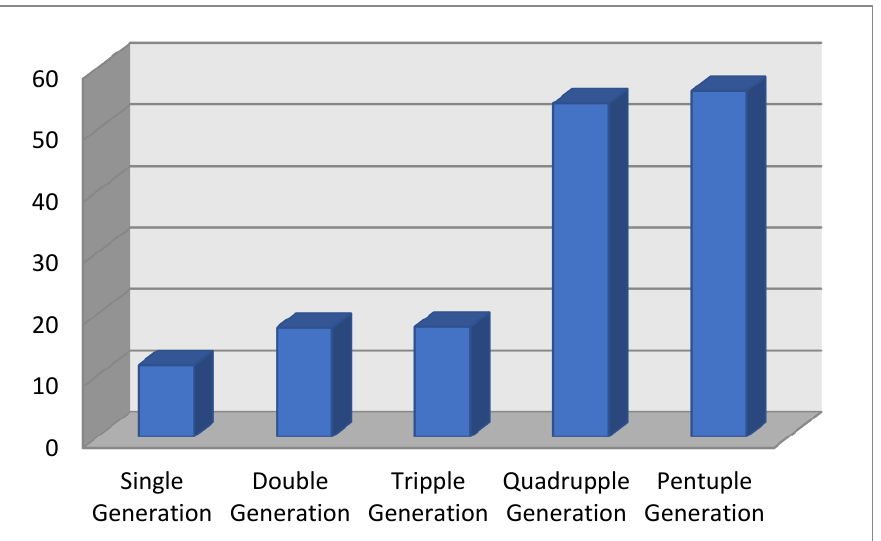
Figure 3. Comparative Bar Plot of Different Energy Efficiencies of Multigeneration System at Different Production Capacities .